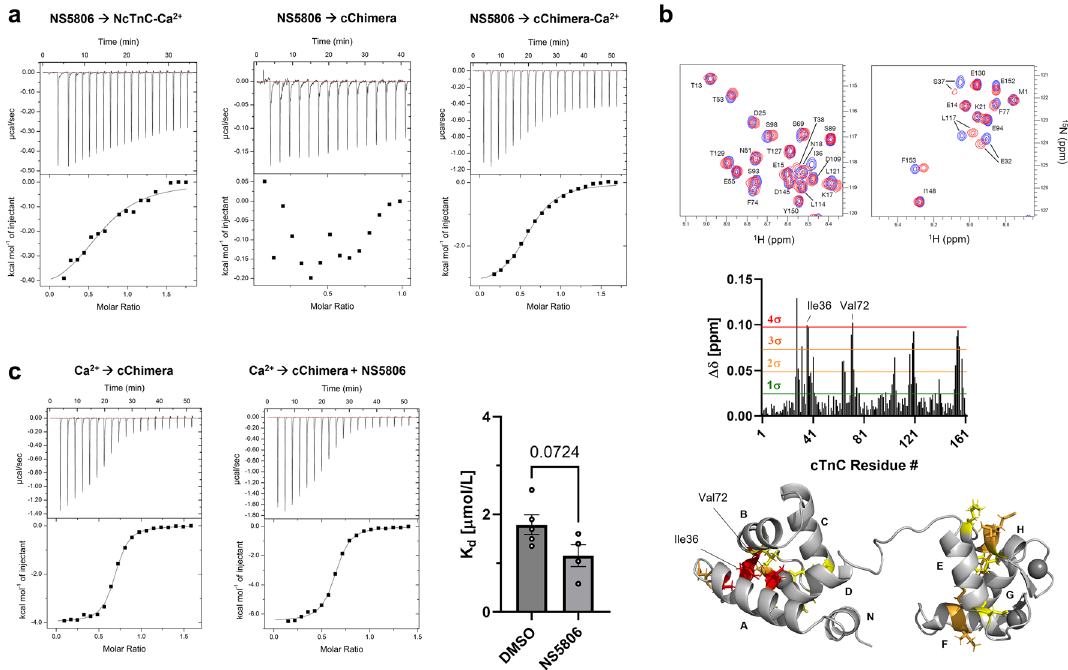
Figure 3. Biophysical characterization of NS5806-cTnC interaction. ( a ) NS5806 binding to Ca 2+ -bound NcTnC (left), Ca 2+ -free cChimera (middle) and Ca 2+ -bound cChimera monitored by isothermal titration calorimetry (ITC). ( b ) Top: Part of 2D- 1 H- 15 N HSQC spectrum of cTnC in the absence (blue) and in the presence (purple) of NS5806 at roughly 1:1 stoichiometry. Middle: Plot of chemical shift perturbations (∆δ) of cTnC plotted against the amino acid sequence after addition of NS5806. Thresholds for different multiples of the standard deviation (SD) are shown in red. Bottom: Chemical shift perturbations mapped onto cTnC structure. Ile36 and Val72 are labelled accordingly. ( c ) ITC binding isotherm for Ca 2+ titrated into cChimera in the absence (left) and in the presence (right) of NS5806. Means ± SEM, n = 4–5. Statistical significance between control and drug treatment was assessed with an unpaired two-tailed student’s